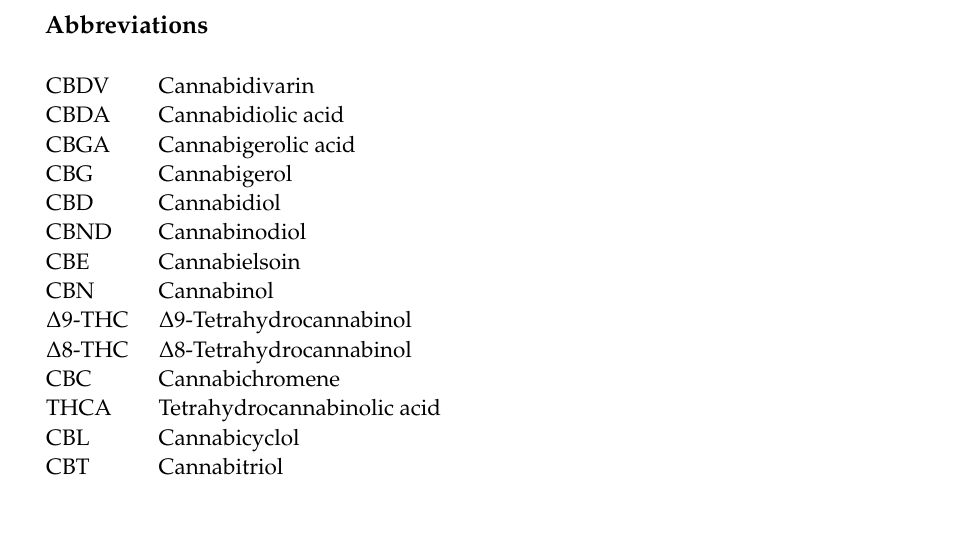
Figure S1-b: Chromatogram of S1 D3000 analyzed by RP-UHPLC-PDA; Figure S2-a: Chromatogram of S2 D300 analyzed by RP-UHPLC-PDA; Figure S2-b: Chromatogram of S2 D3000 analyzed by RP-UHPLC-PDA; Figure S3-a: Chromatogram of S3 D300 analyzed by RP-UHPLC-PDA; Figure S3-b: Chromatogram of S3 D3000 analyzed by RP-UHPLC-PDA; Figure S4-a Chromatogram of S4 D300 an- alyzed by RP-UHPLC-PDA; Figure S4-b: Chromatogram of S4 D3000 analyzed by RP-UHPLC-PDA; Figure S5-a: Chromatogram of S5 D300 analyzed by RP-UHPLC-PDA; Figure S5-b: Chromatogram of S5 D3000 analyzed by RP-UHPLC-PDA; Figure S6-a: Chromatogram of S6 D300 analyzed by RP- UHPLC-PDA; Figure S6-b: Chromatogram of S6 D3000 analyzed by RP-UHPLC-PDA; Figure S7-a: Chromatogram of S7 D3000 analyzed by RP-UHPLC-PDA; Figure S7-b; Chromatogram of S7 D300 analyzed by RP-UHPLC-PDA; Figure S8-a: Chromatogram of S8 D300 analyzed by RP-UHPLC- PDA; Figure S8-b: Chromatogram of S8 D3000 analyzed by RP-UHPLC-PDA; Figure S9-a: Chro- matogram of S9 D300 analyzed by RP-HPLC-PDA; Figure S9-b: Chromatogram of S9 D3000 analyzed by